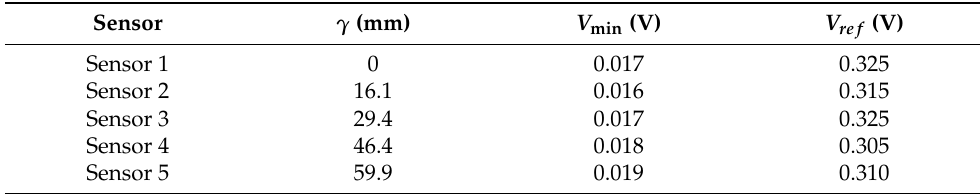
Table 1. Position of the linear shaft where each sensor reaches its minimum value from the output and its reference voltage.